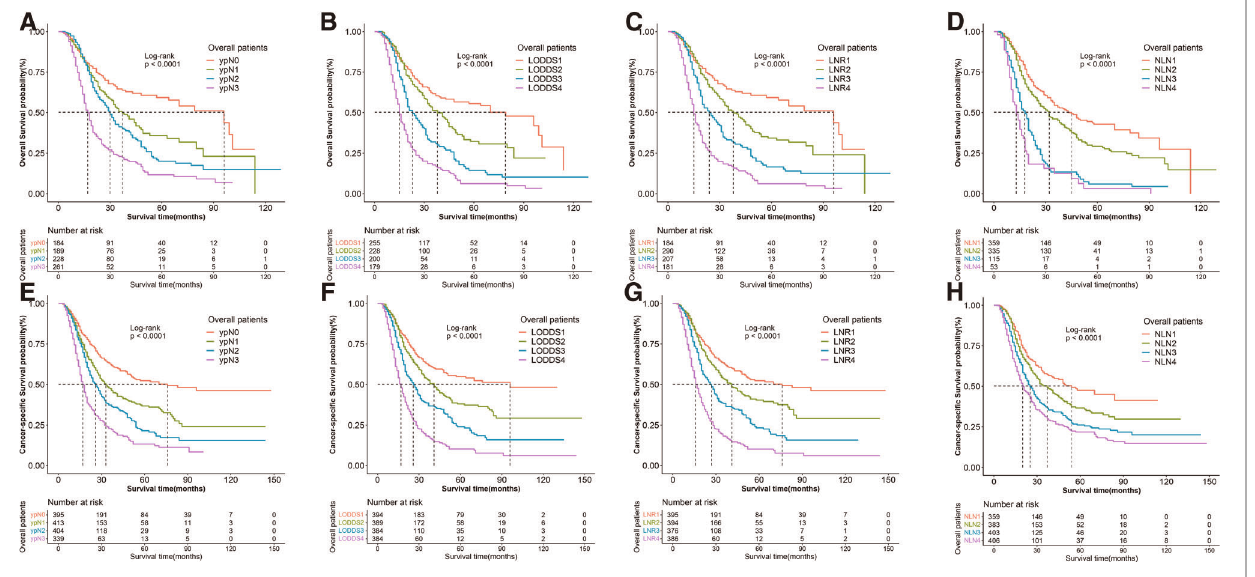
FIGURE 2 | Kaplan – Meier survival curves of OS according to ( A ) N stage, ( B ) LODDS, ( C ) LNR, and ( D ) NLN staging systems and CSS according to ( E ) N stage, ( F ) LODDS, ( G ) LNR and ( H ) NLN staging system for gastric adenocarcinoma patients after NAT.OS, overall survival; CSS, cancer speci fi c survival; LNR, lymph node ratio; LODDS, log odds of positive lymph node; NLN, negative lymph node; NAT, neoadjuvant